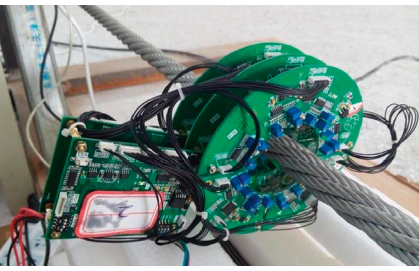
Figure 6: MFL detection device. Table 5: The characteristic samples of MFL signals of broken